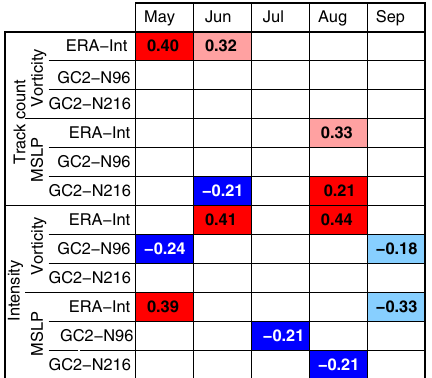
Figure 7. Pearson correlation coefficients between May, June, July, August and September cyclone characteristics (over ocean and ice points only) and September mean sea ice extent. Dark red squares denote positive correlations significant at the 95% confidence level, light red squares denote positive correlations significant at the 90% confidence level, dark blue squares denote negative correlations sig- nificant at the 95% confidence level and light blue squares denote negative correlations significant at the 90% confidence level. Cor- relation coefficients are not shown where the confidence level is less than